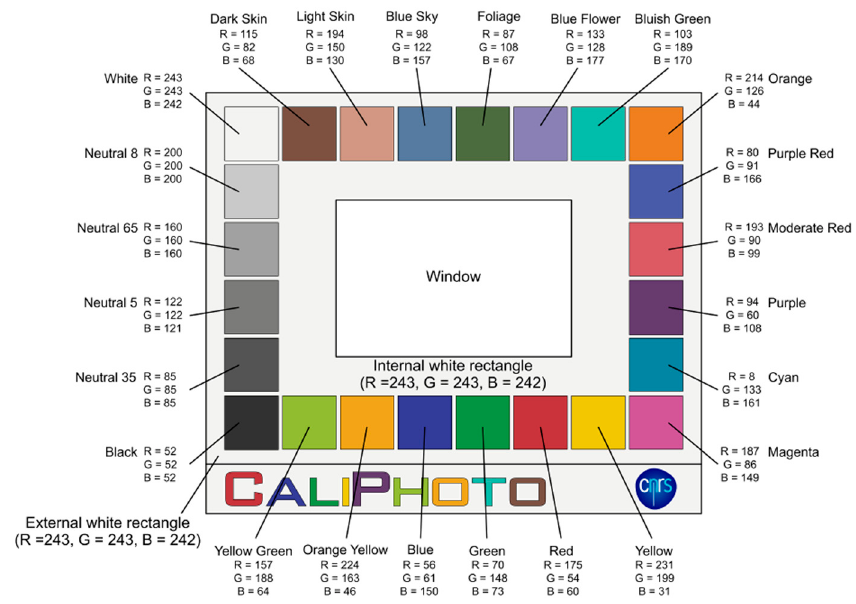
Figure 1. Model of the CaliPhoto colour plate. The colour plate consists of a white 4:3 ratio rectangle (without the logo band), surrounded by 24 squares of di ff erent colours arranged in a rectangle, surrounding another white rectangle. At the centre of the colour plate is a rectangular window in which the sample will be observed. The 8 bit RGB values of each square, chosen in this study to correspond to the GretagMacBeth ColorChecker values, and of the internal and external white rectangles are displayed.